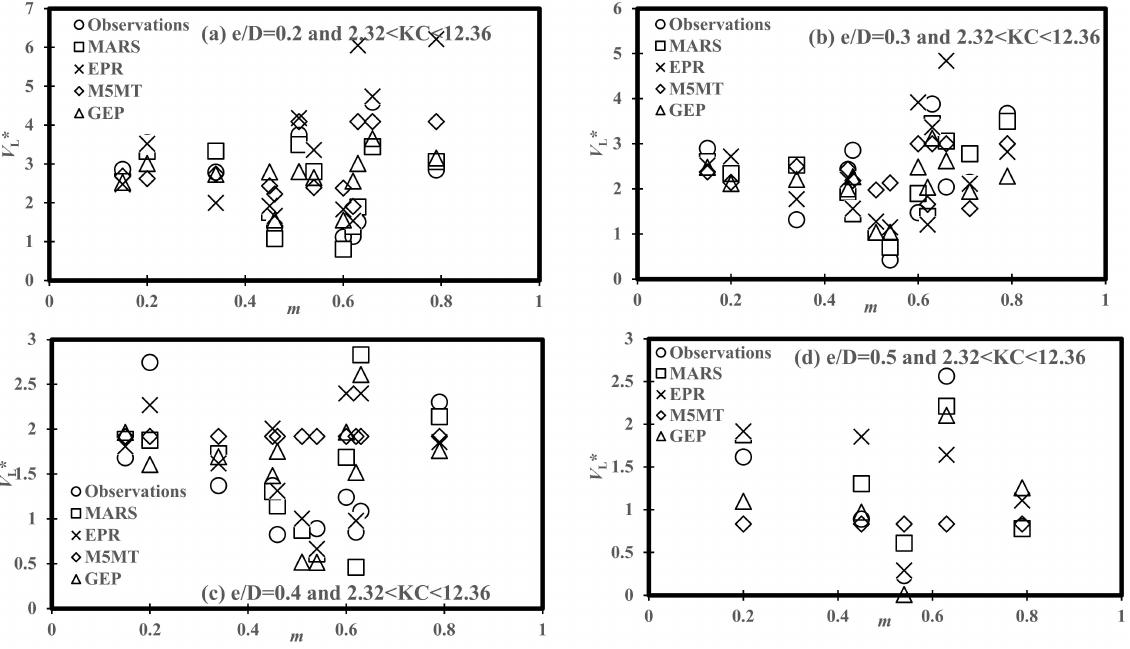
Figure 8. Comparisons of the soft computing models’ performance for variation of V L * versus m in for various levels of e / D : ( a ) e / D = 0.2, ( b ) e / D = 0.3, ( c ) e / D = 0.4, and ( d ) e / D =